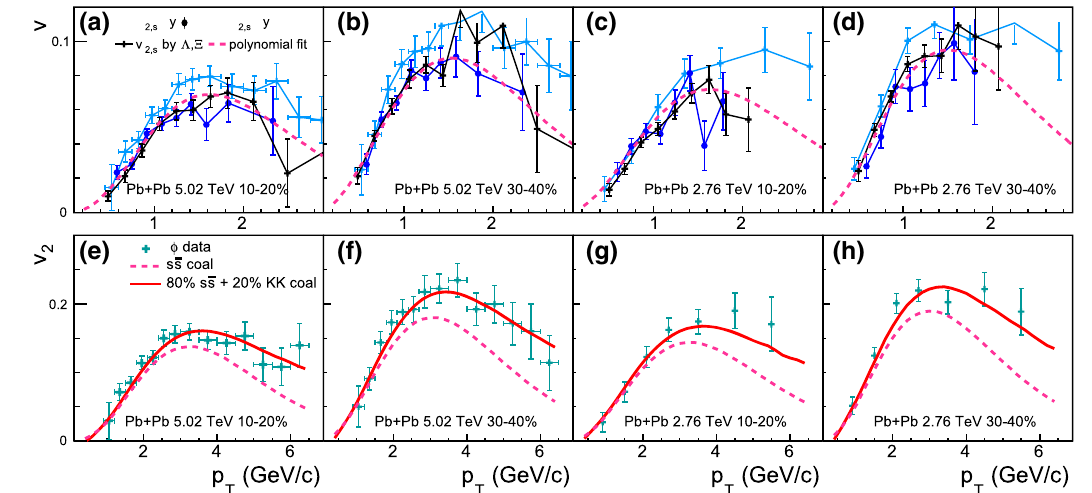
Fig. 4 Top panels: v 2 , s ( p T ) extracted from data of strange hadrons [7,26,27].Thedashedlinesarepolynomialfitsof v 2 , s ( p T ) fromstrange baryons. Bottom panels: The v 2 of φ . Symbols are data of φ [7,26,27].